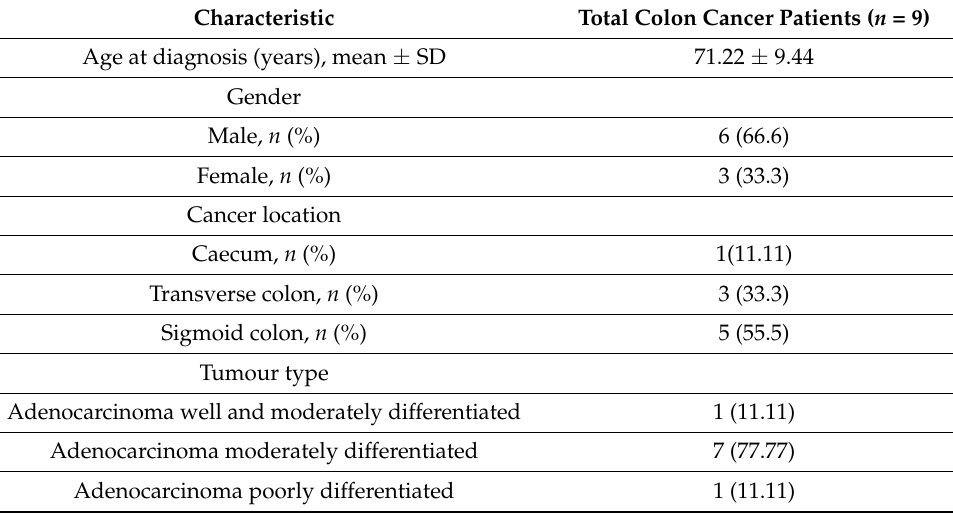
Table 1. Demographic characteristics of the cohort of patients with colon cancer ( n =